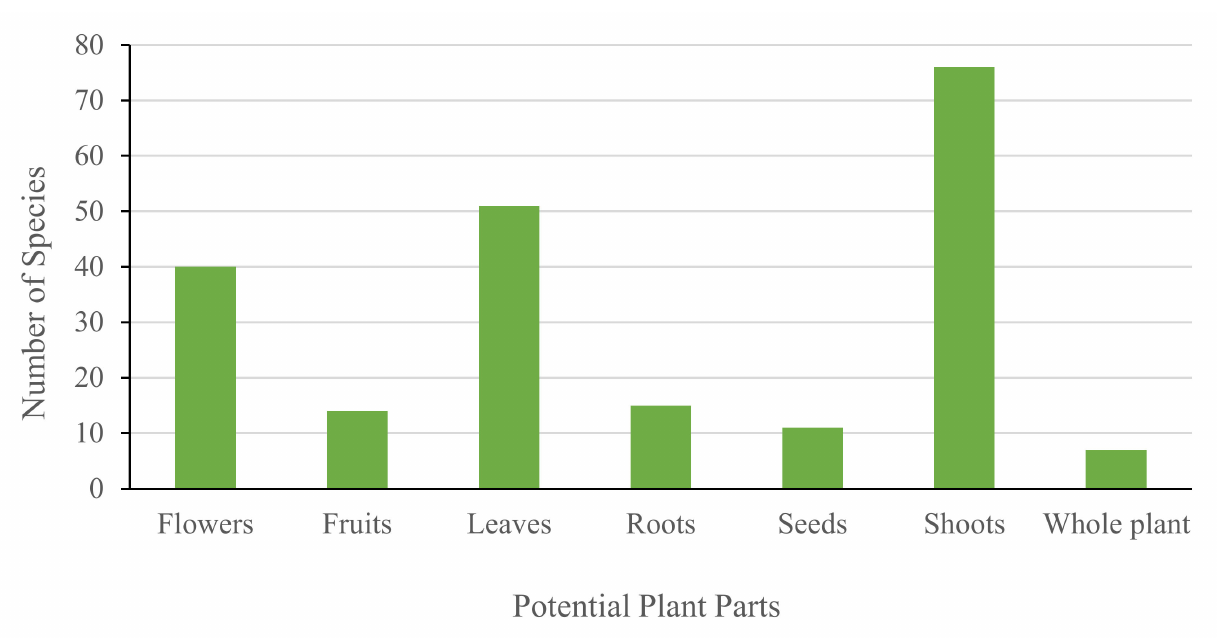
Figure 2. Habitats of EO-bearing plants in the UAE.